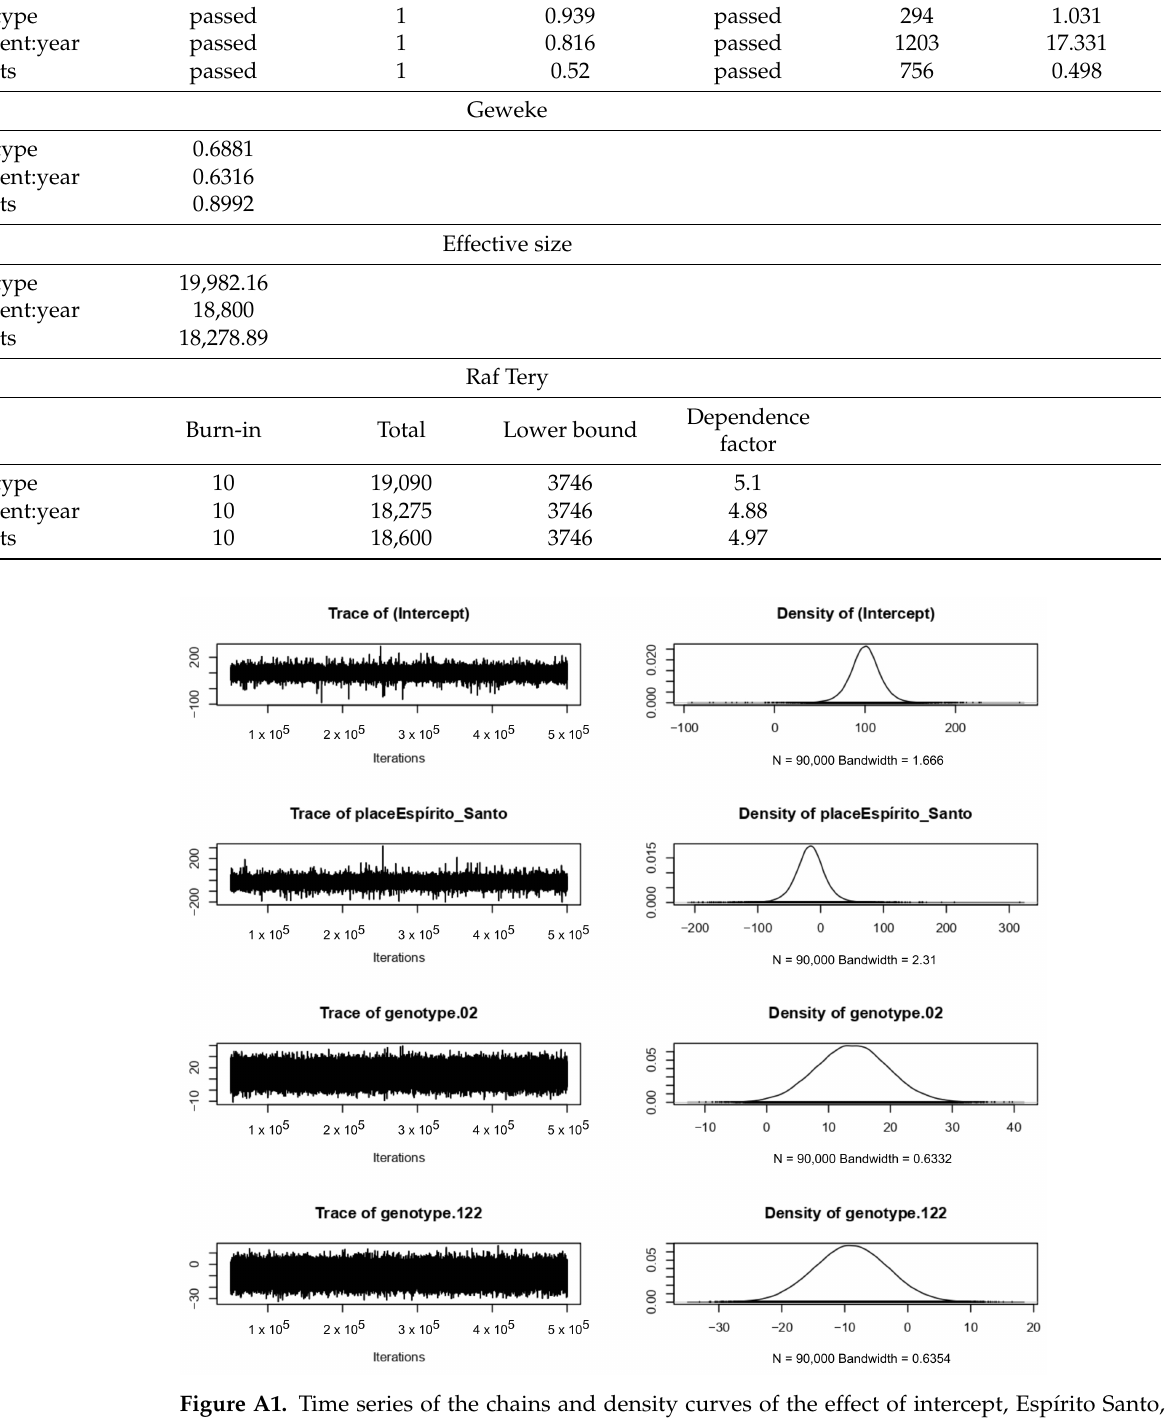
Figure A1. Time series of the chains and density curves of the effect of intercept, Espírito Santo, genotype 02, and genotype 122.